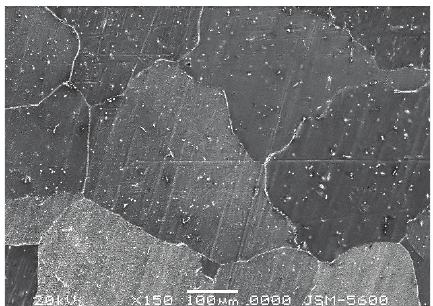
Figure 2: SEM micrograph of specimen